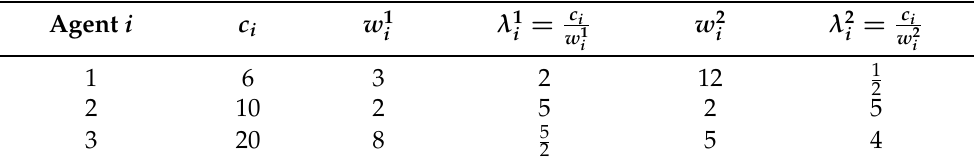
Table 1. A double-weighted bankruptcy situation ( E , c , w 1 , w 2 ) with N = { 1,2,3 } as set of agents and estate E =